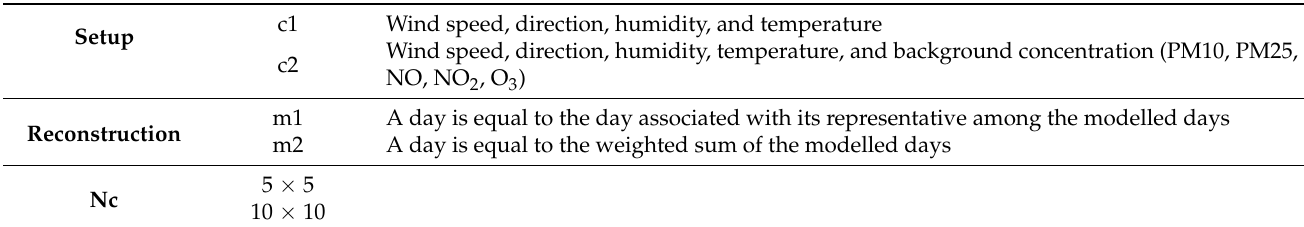
Table 2. List of tested classifications